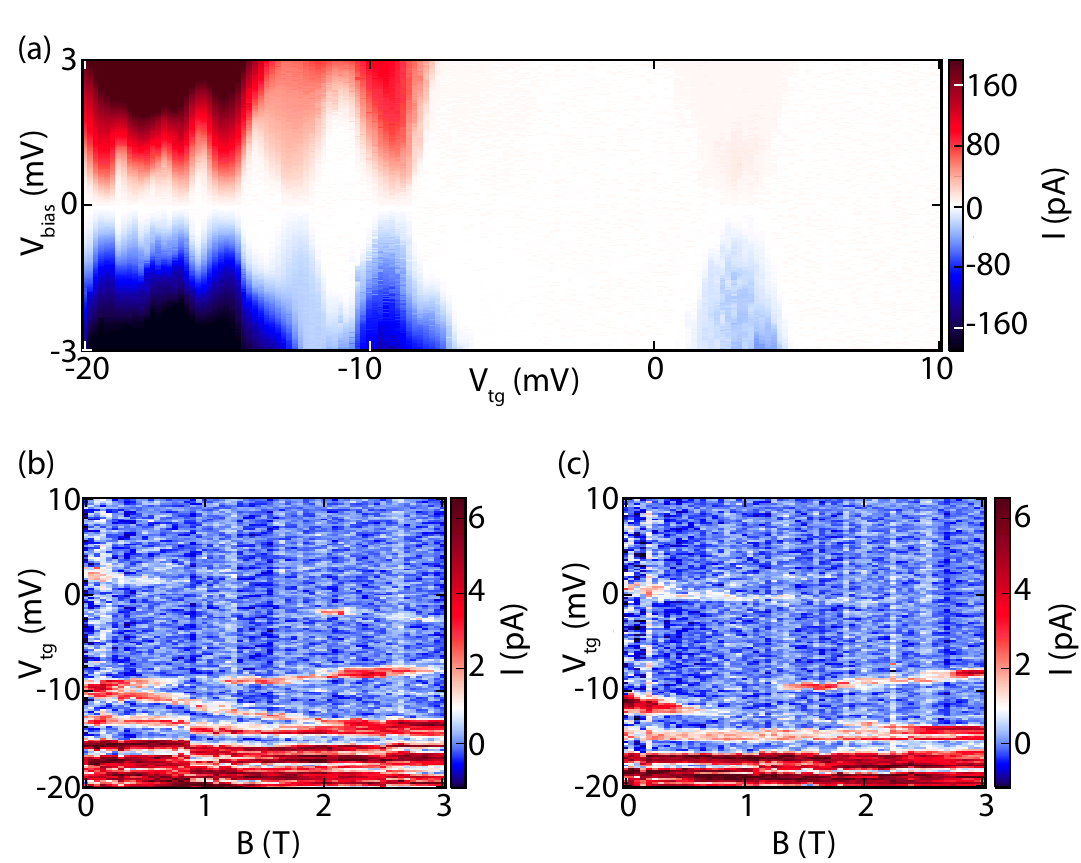
Figure S8: Hole quantum dot in device 2. Different state of the device can be ex- plained by charge jumps occuring after Fig.5 was measured. (a) Current through the nanowire on the valence band side. It is possible that states at V mV originate from another quantum dot that has smaller coupling to contact